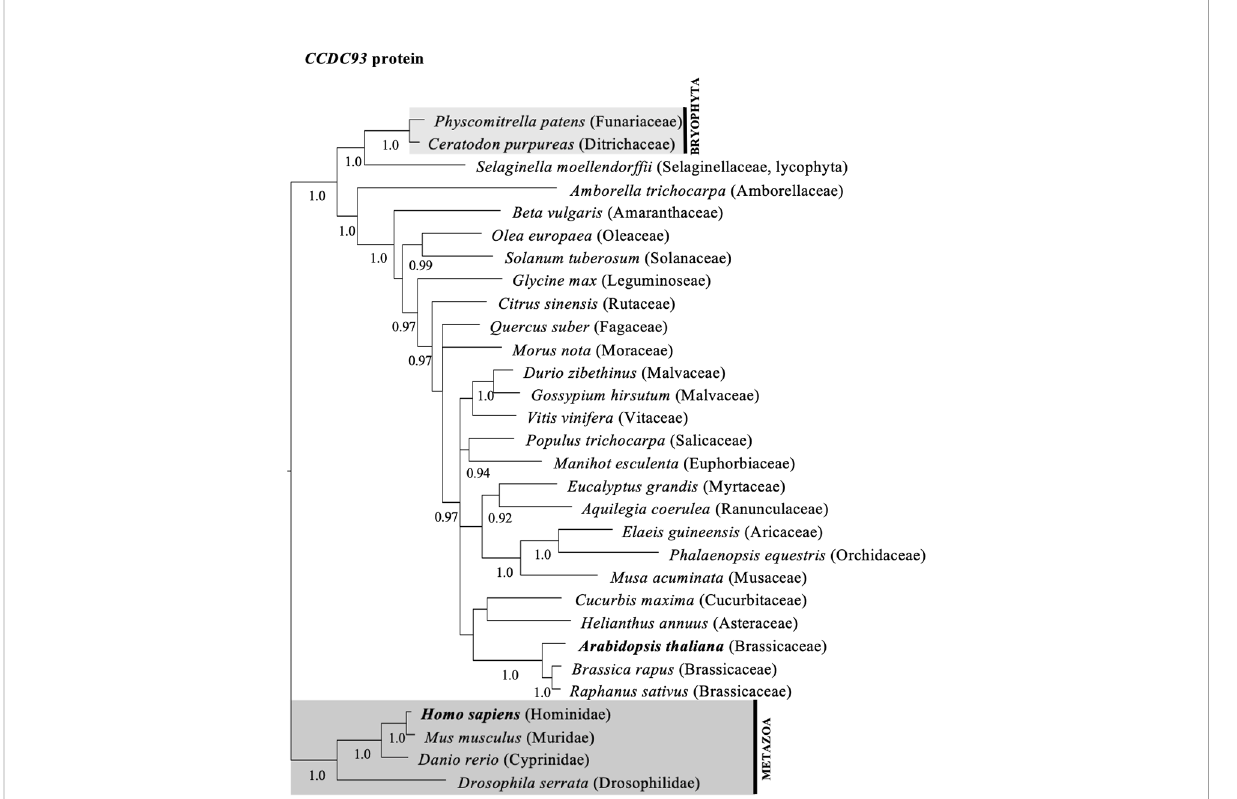
FIGURE 4 Majority rule consensus tree based on Bayesian phylogenetic analyses of aligned CCDC93 protein sequences. Numbers below branches denote Bayesian posterior probabilities above 0.89. CCDC proteins/genes from Arabidopsis and humans are in bold, and shaded boxes highlight animals (metazoans; dark grey box) and bryophytes (bryophyta; light grey